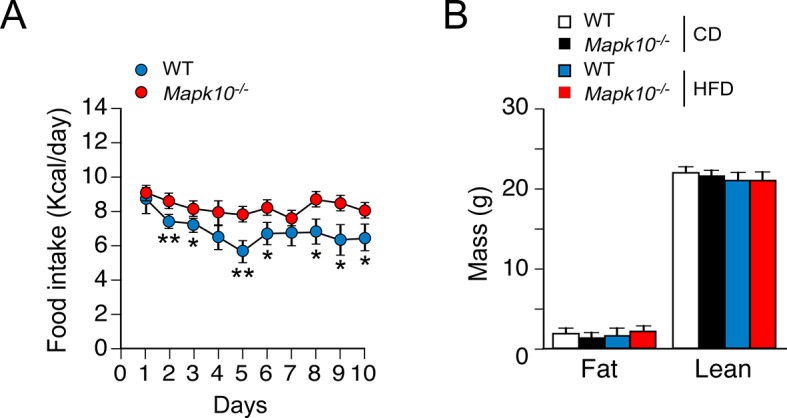
Time course of the development of hyperphagia in HFD-fed JNK3-deficient mice.(A) Metabolic cage analysis of WT and Mapk10-/- mice fed a HFD. The amount of food consumed 7pm – 7am each day was measured (mean ± SEM; n=6; *p<0.05; **p<0.01). (B) Fat and lean body mass of WT and Mapk10-/- mice fed a HFD (3 days) was measured by 1H-MRS analysis (mean ± SEM; n=6). No statistically significant differences were detected (p>0.05).